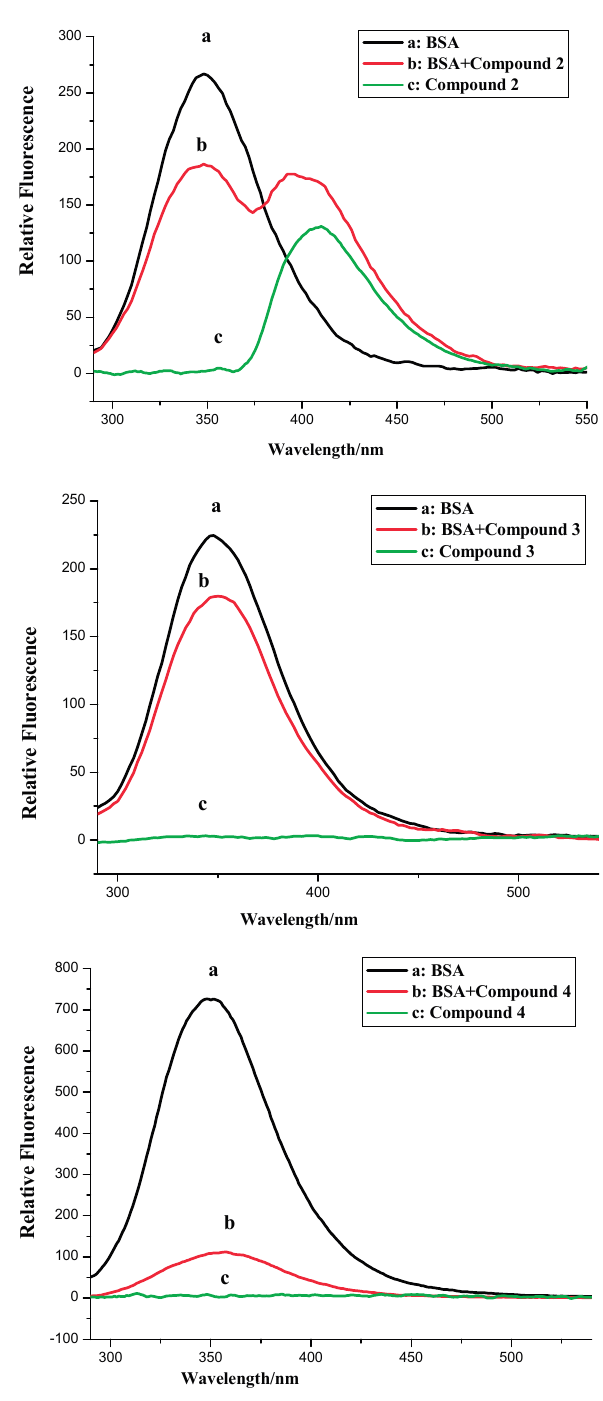
Figure 5. Fuorescence of compounds 1 – 4 , BSA and BSA + compounds 1 – 4